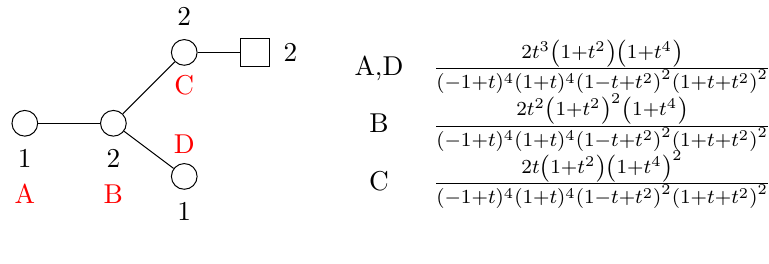
Table 9. The Higgs branch of Sp(2) with N f = 4 consists of two identical cones. The Coulomb branch of this quiver is one of the two cones. B-twisted index with Wilson lines at the labelled position in the quiver.